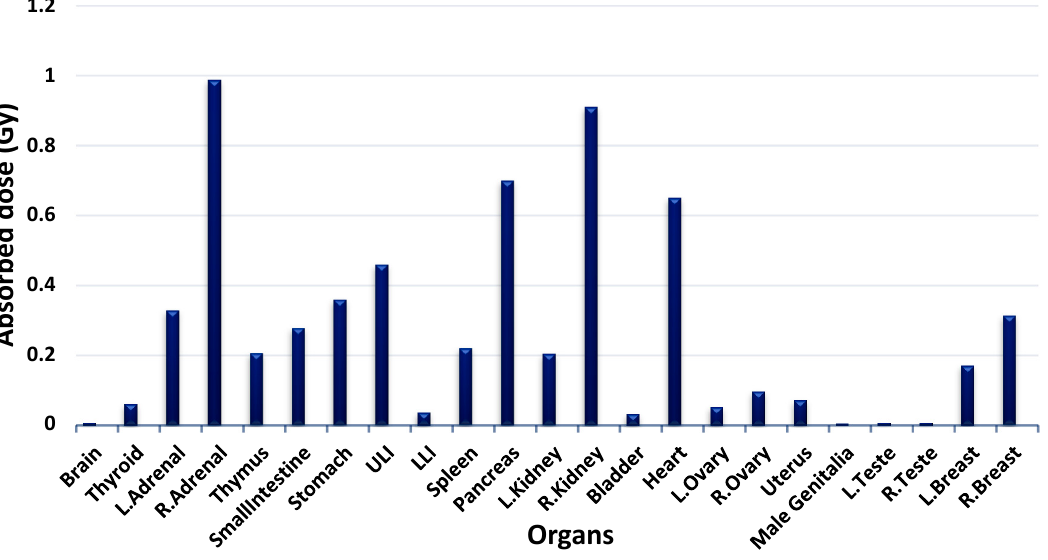
Figure 9. Absorbed dose to other organs for tumour involvement of 70%, lung shunting (LS) (20%), and tumour to normal liver uptake ratio (T/N) 1, when 120 Gy is delivered to the tumour. L: left, R: right, ULI: upper large intestines, LLI: lower large intestines.